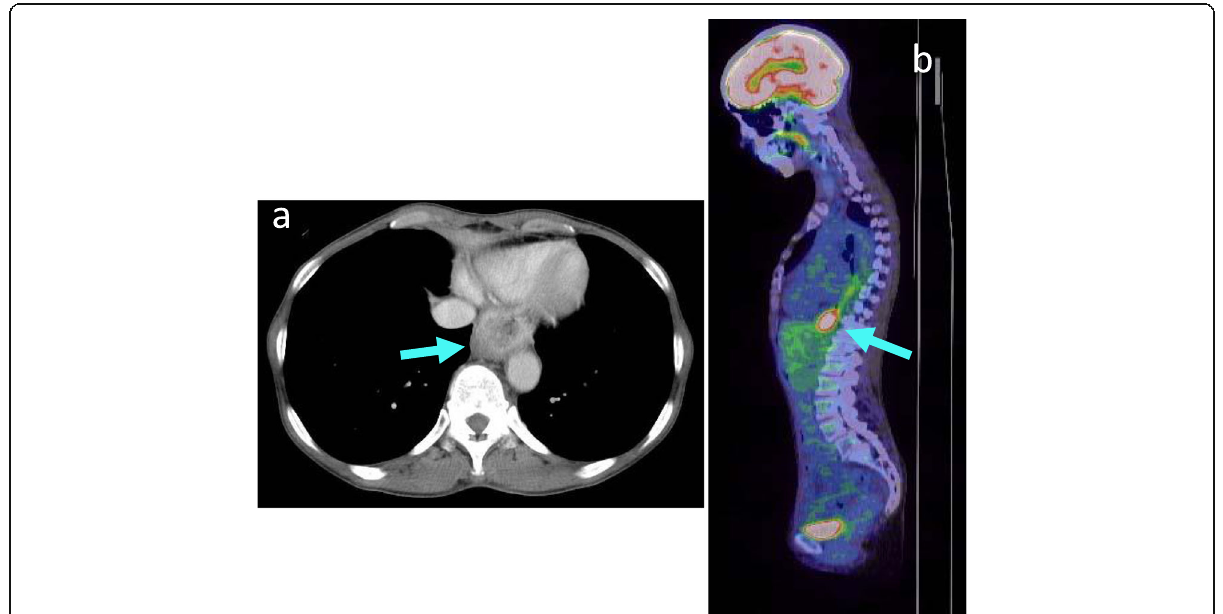
Fig. 5 CT and PET/CT 1 year and 6 months later. a CT scan found the obvious wall thickening at the lower esophagus (arrows). b PET/CT showed increased FDG uptake in the lower esophagus (SUV max, 9.5) (arrows)